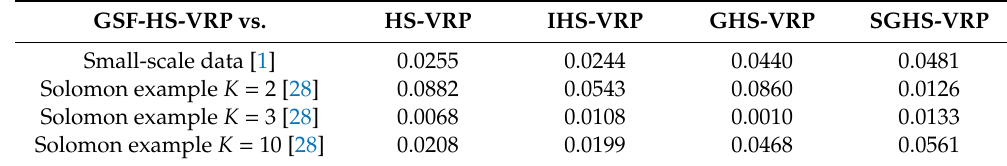
Table 10. p -Values produced by Wilcoxon’s test for the di ff erent